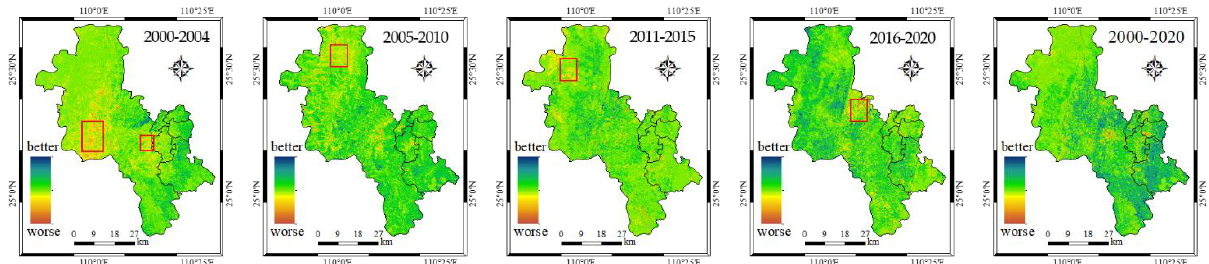
Figure 5. Change map of RSEI in the main urban area of Guilin from 2000 to 2020 with five-year intervals. The red box indicates the area with a large range of rsei reduction in the past five years, which refers to the area with poor ecological environment. Table 6. RSEI class and area statistics.